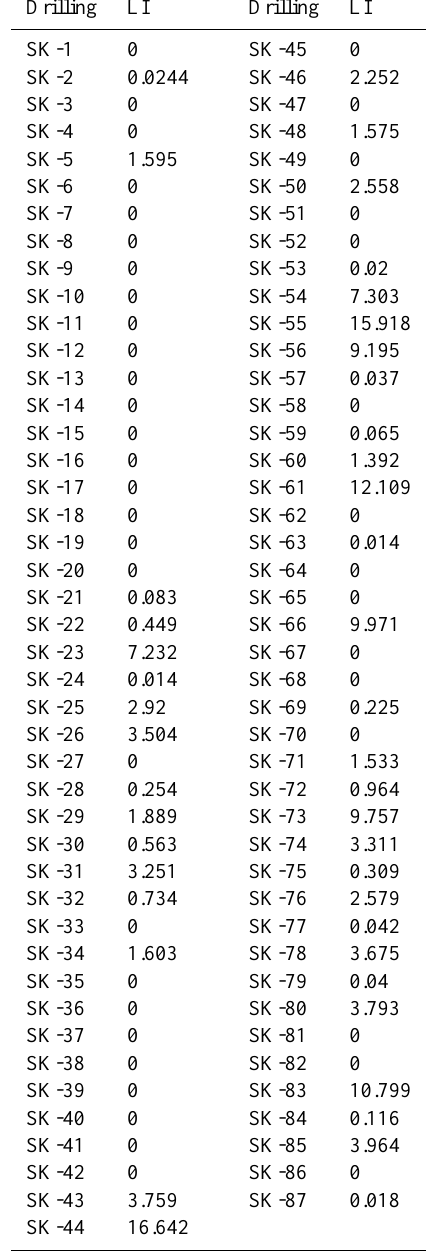
Table 3. Liquefaction index values acquired across a 20m depth. Drilling